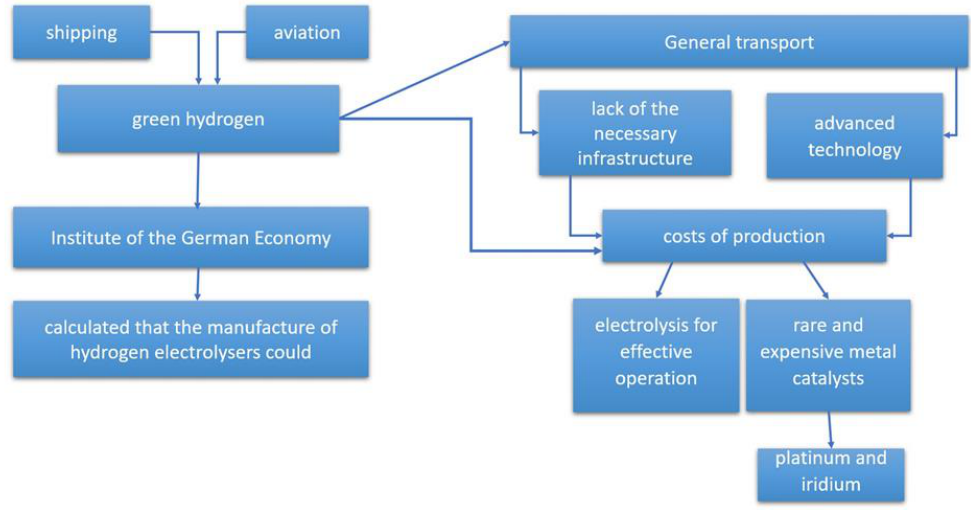
Figure 2. Green hydrogen in Germany [51] .